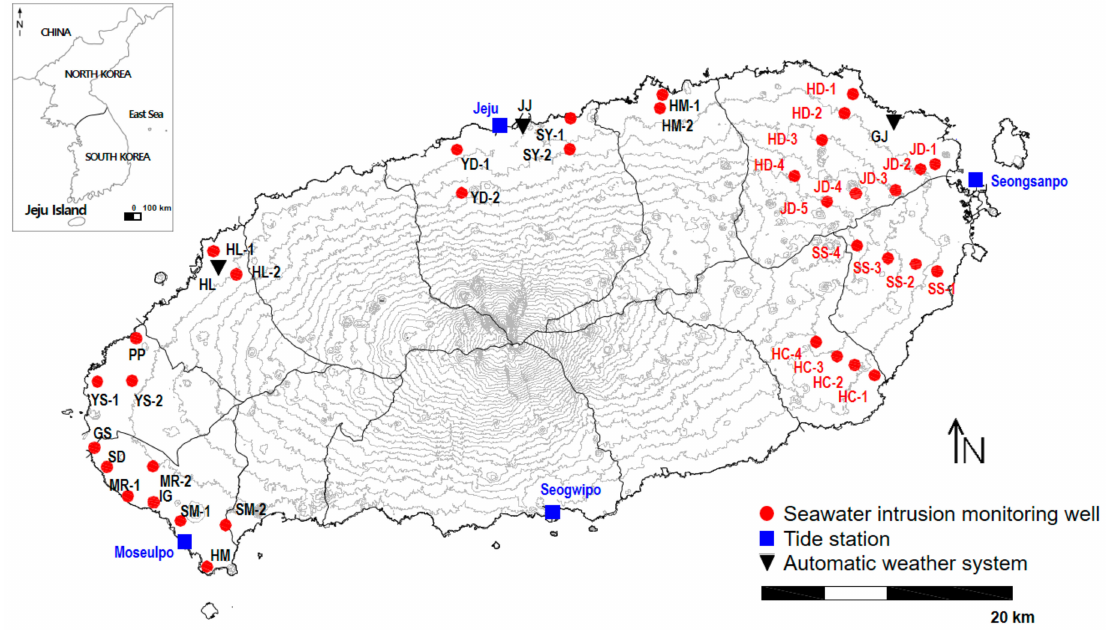
Figure 1. Locations of seawater intrusion monitoring wells, tide stations, and automatic weather systems on Jeju